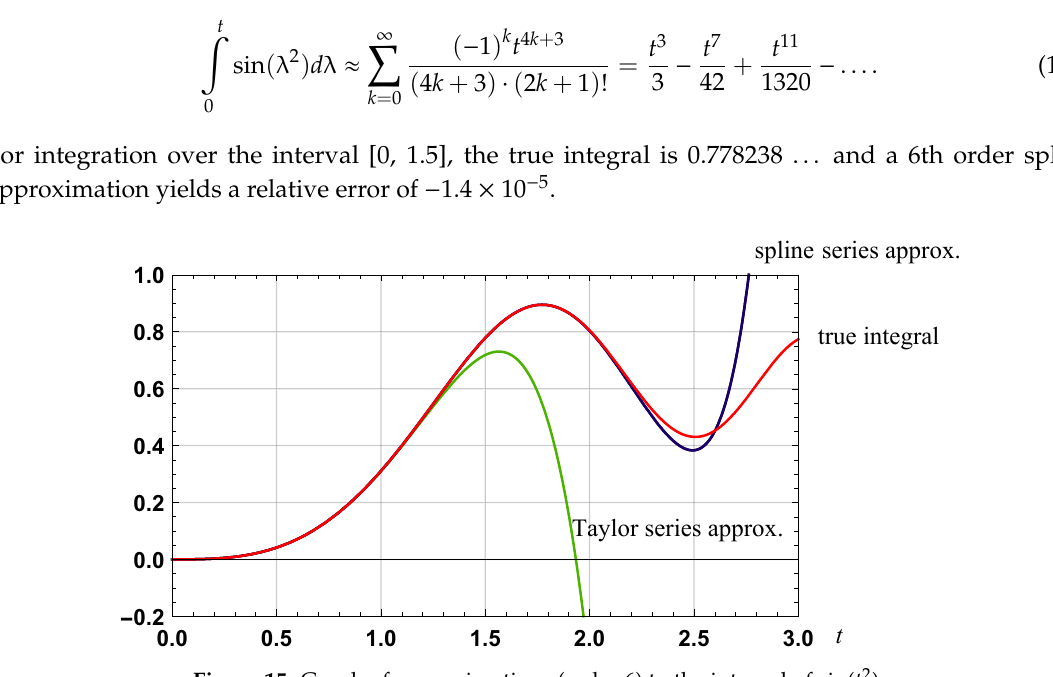
Figure 15. Graph of approximations (order 6) to the integral of sin( t 2 .